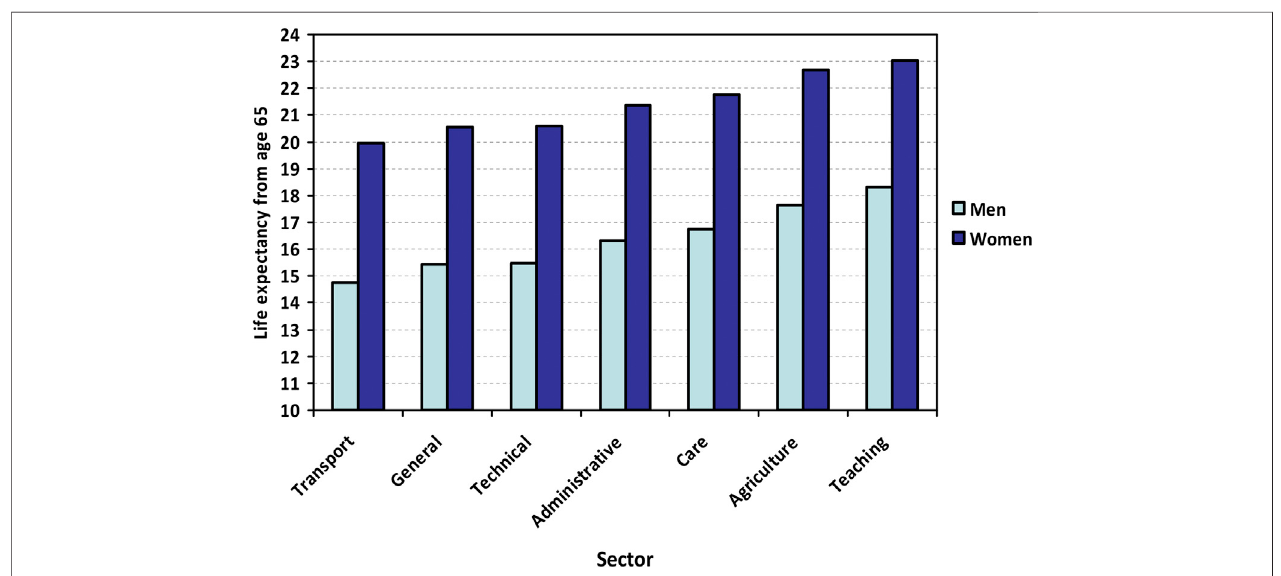
FIGURE 1 | Life expectancy by occupational domain for men (light colors) and women (dark colors) at age 65. Note: The data are based on analysis of domain speci fi c relative survival using the full sample, the results of which are compared to the population-based sex-speci fi c survival curves at age 65 in order to obtain life expectancies ( Supplementary Figure A ). Source: Longitudinal Aging Study Amsterdam, 1992 – 93 to